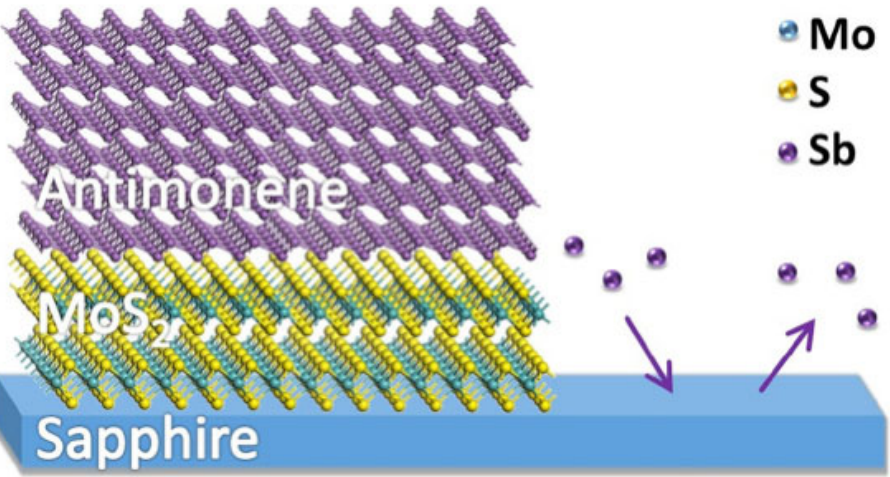
Figure 8. Growth of antimonene on MoS 2 /sapphire. Reprinted with permission from Ref. [10]. Copyright 2018, American Chemical Society.